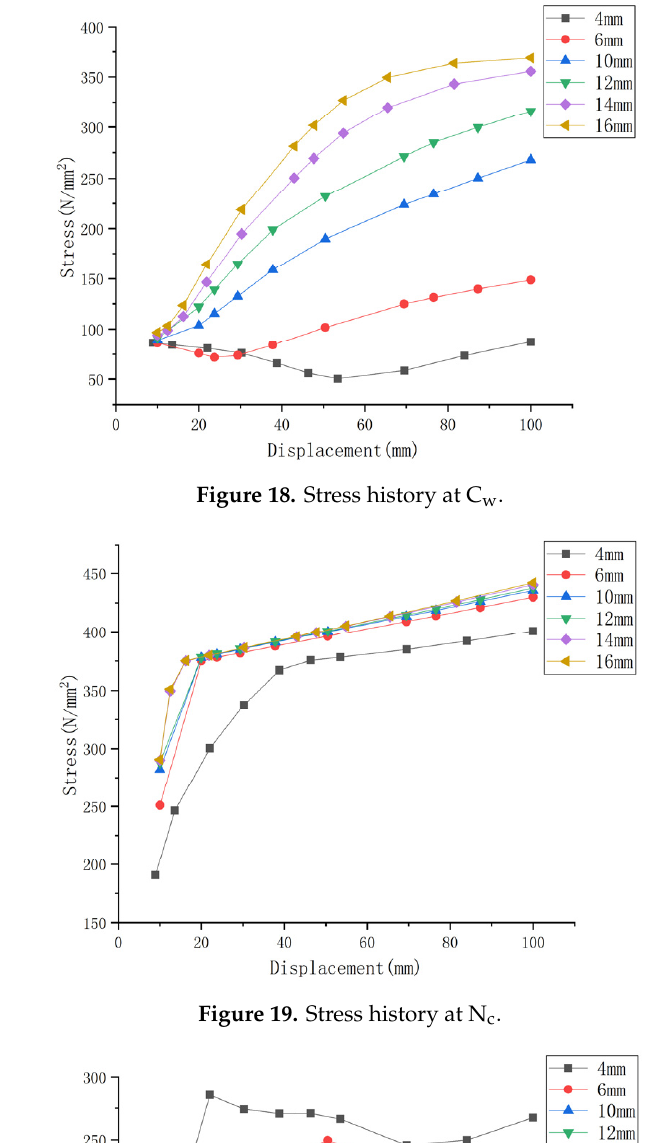
Figure 19. Stress history at N c .